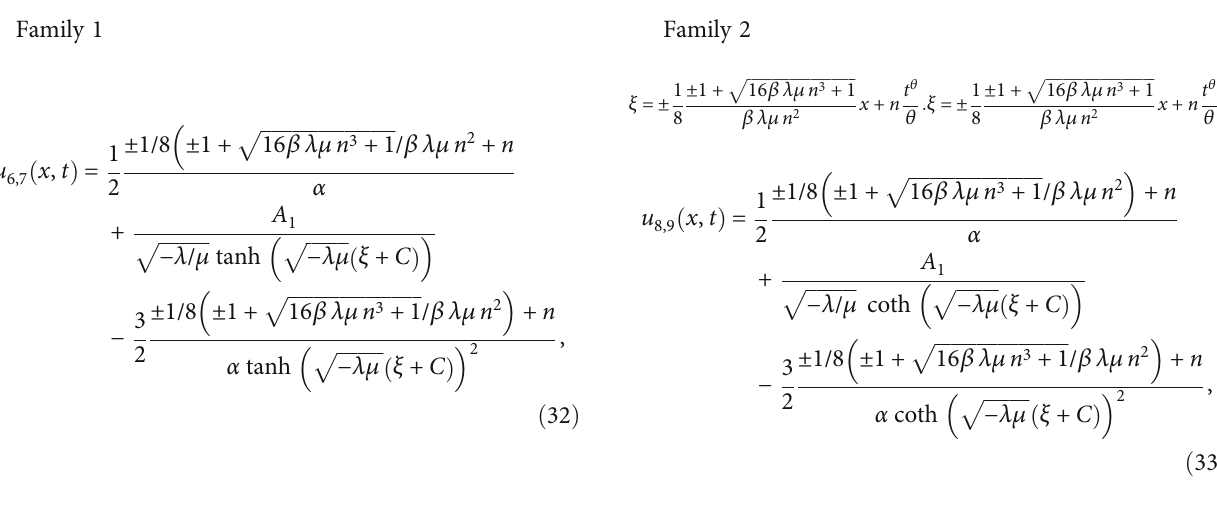
, t Þ . (a, b) 3D plot and (c) 2D combined plot for x = 1 14,15 ð x